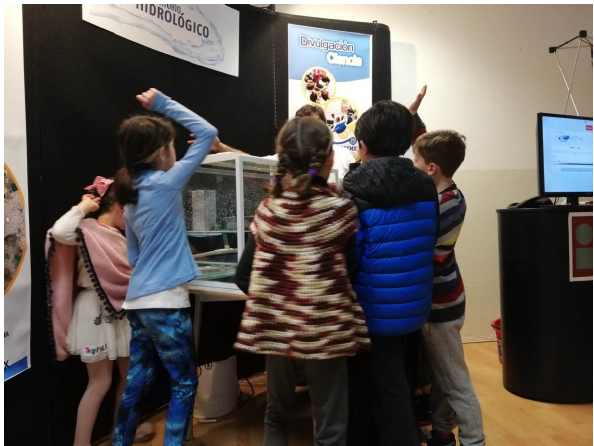
Figure 5. Group of students participating in the “urban water phys- ical model”